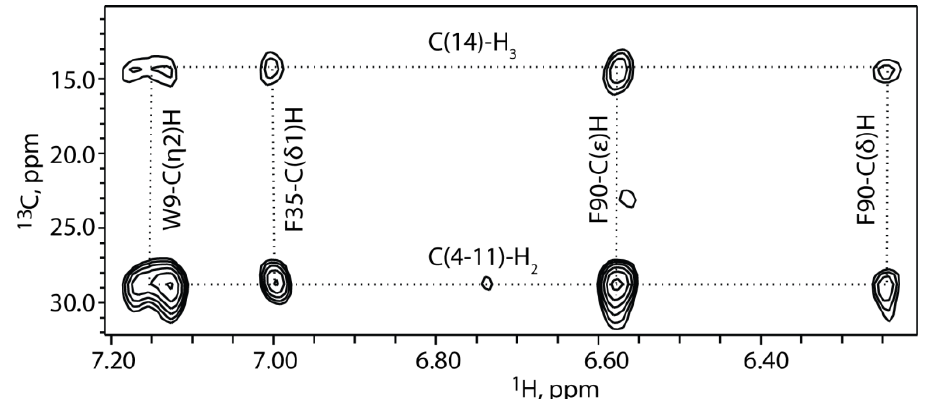
Figure 3. 2D 1 H- 13 C HMQC-NOESY data obtained for FIV myrMA Q5A/G6S prepared using